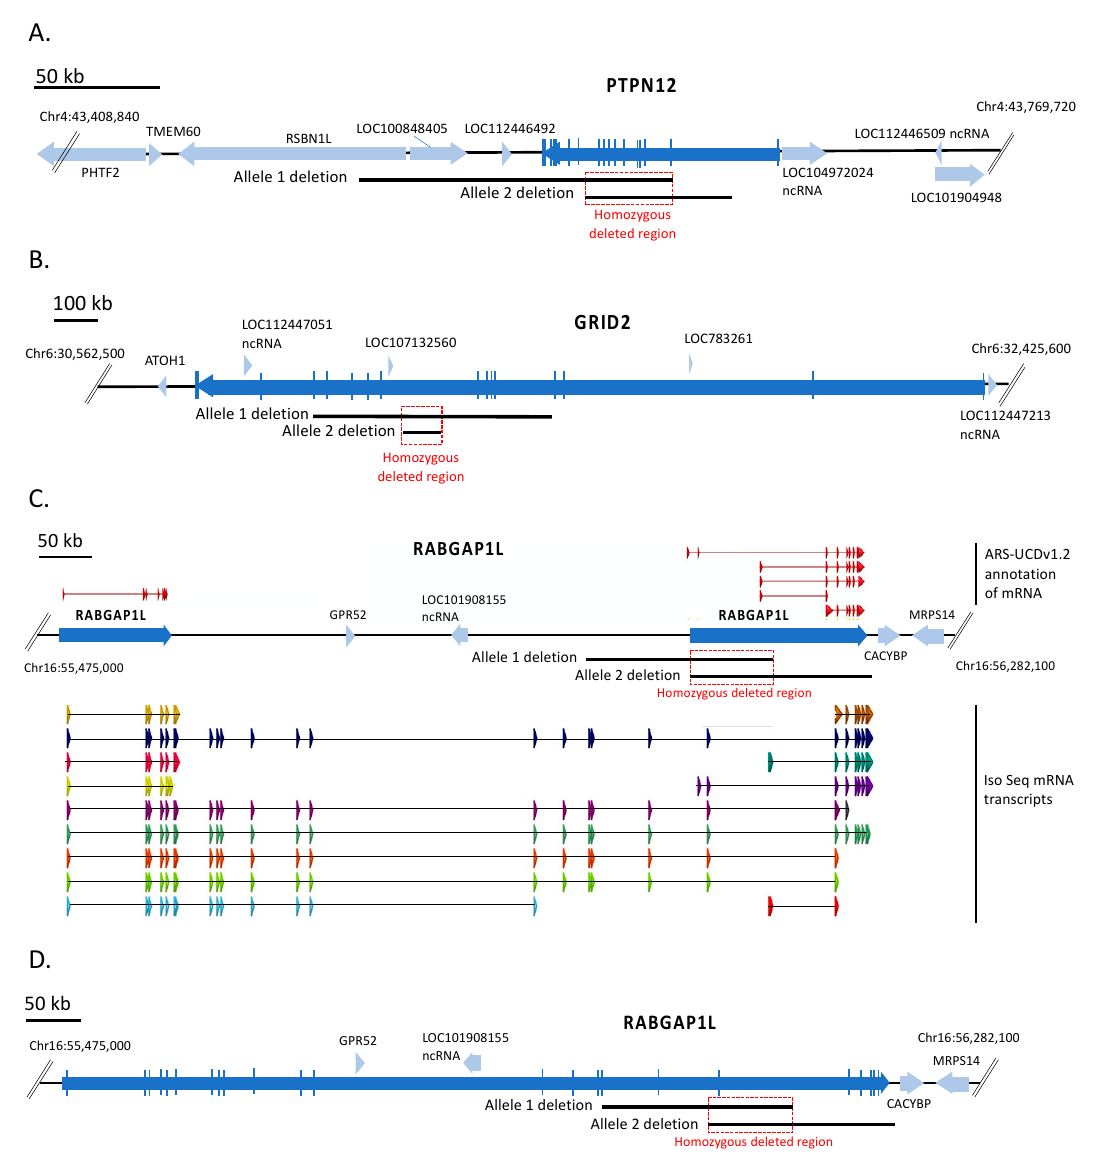
Figure 1. Physical maps of the three large homozygous deleted regions in the CRIB cell line. Genome map of ARS-UCD1.2 in the region of the three large homozygous deleted regions. Blue arrows, genes (open reading frames); black lines, overlapping heterozygous deletion alleles; red box, homozygous deleted region. Panel ( A ) heterozygous deletion alleles of PTPN12 on chromosome 4. Panel ( B ) heterozygous deletion alleles of GRID2 on chromosome 6. Panel ( C ) heterozygous deletion alleles of RABGAP1L on chromosome 16. Shown on top of the bovine map are the transcripts annotated for RABGAP1L in the Hereford ARS-UCD1.2 reference genome. Below the map are IsoSeq transcripts from multiple cattle breeds (see Methods). Panel ( D ), genome map with the full-length bovine RABGAP1L gene as determined using IsoSeq transcripts. The PTPN12 gene on chromosome 4 encodes the protein tyrosine phosphatase non- receptor type 12 protein. The CRIB cell line PTPN12 gene contained a 57,648 bp deletion on one chromosome spanning exons 2–11, and a 123,042 bp deletion spanning exons 3–18 on Table 2. Gene functions. the other chromosome. These heterozygous deletions overlapped resulting in a 33,808 Cellular Localization Gene Gene Function and Expression Member of the protein tyrosine phosphatase Cytosol; ubiquitously (PTP) family; plays role in cytoskeletal struc- PTPN12 expressed ture, cell adhesion, cell shape and mobility, and cell-cell junctions [32]